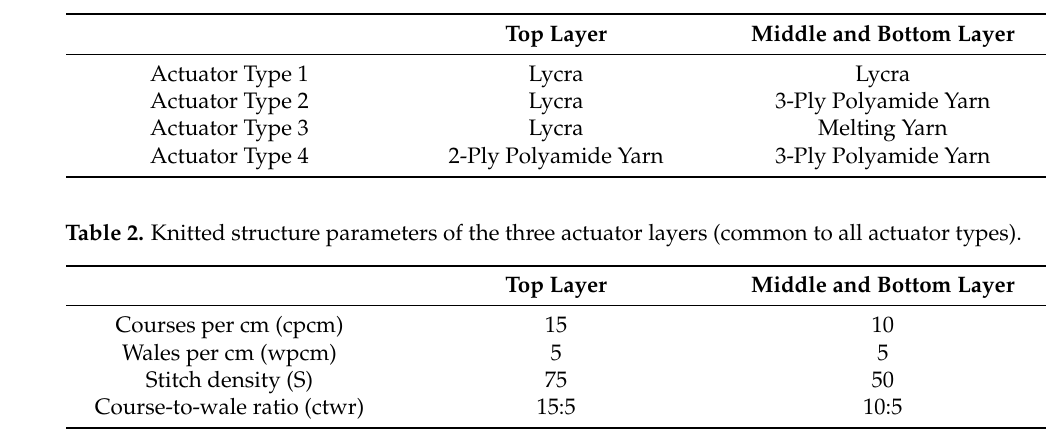
Table 1. Yarn combinations of actuator layers for each actuator type.